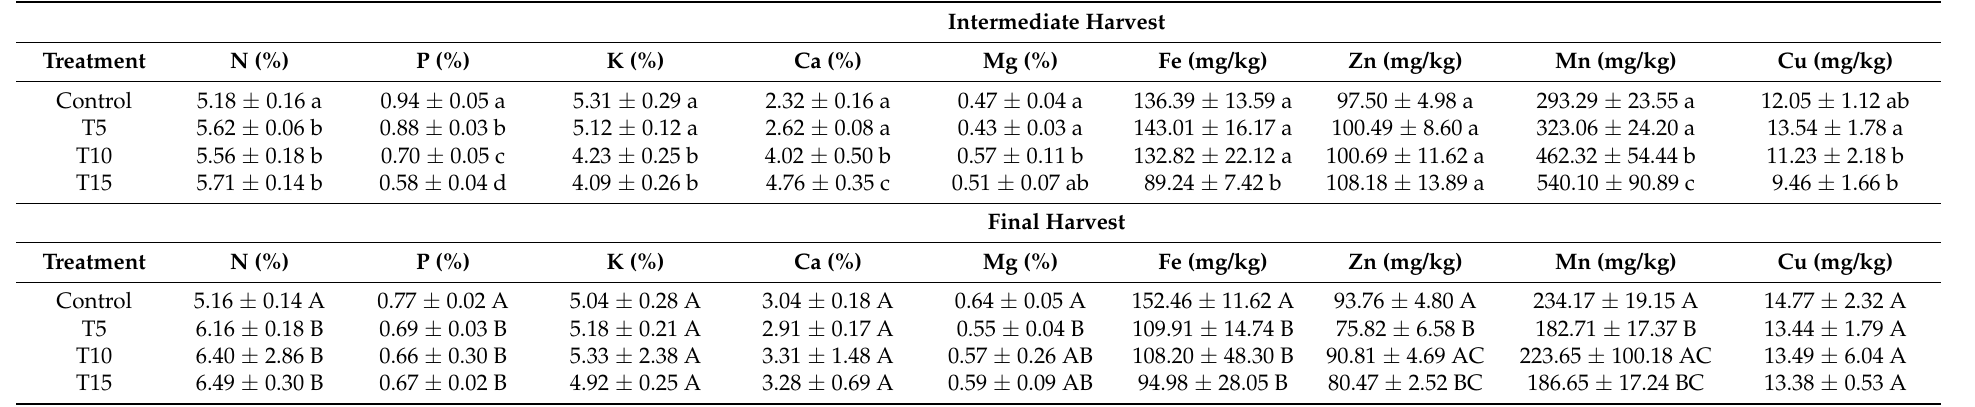
Table 3. Nutrient concentrations in basil leaves for various salinity treatments (1st experiment) as determined at intermediate and final harvests. Different letters indicate statistically significant differences between treatments at each harvest (small letters refer to the intermediate and capital ones to the final harvest, p < 0.05). Values in all layers are expressed as mean ± standard deviation ( n =